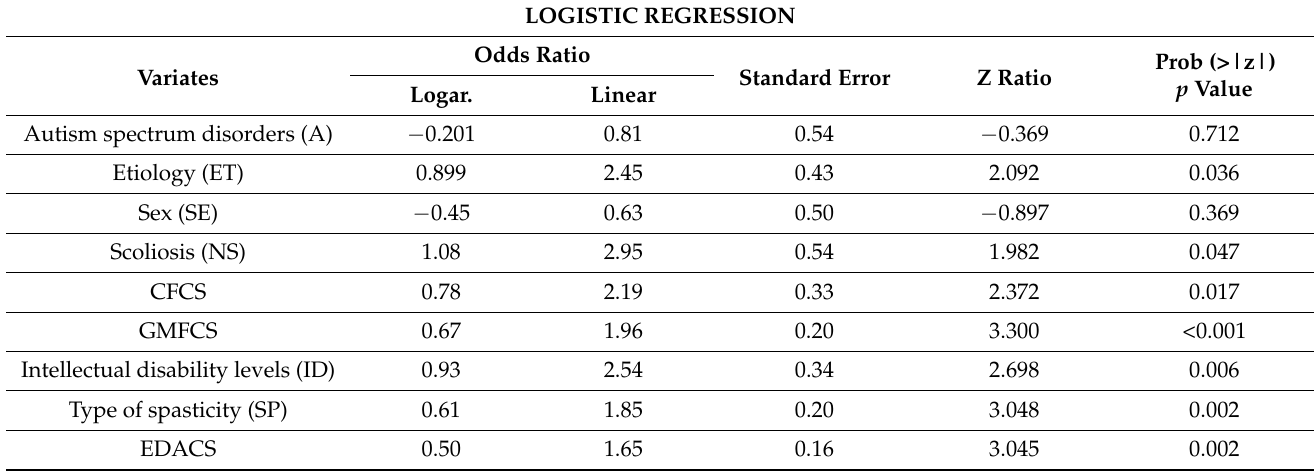
Table 3. Logistic multi-regression. The dependent variable was epilepsy